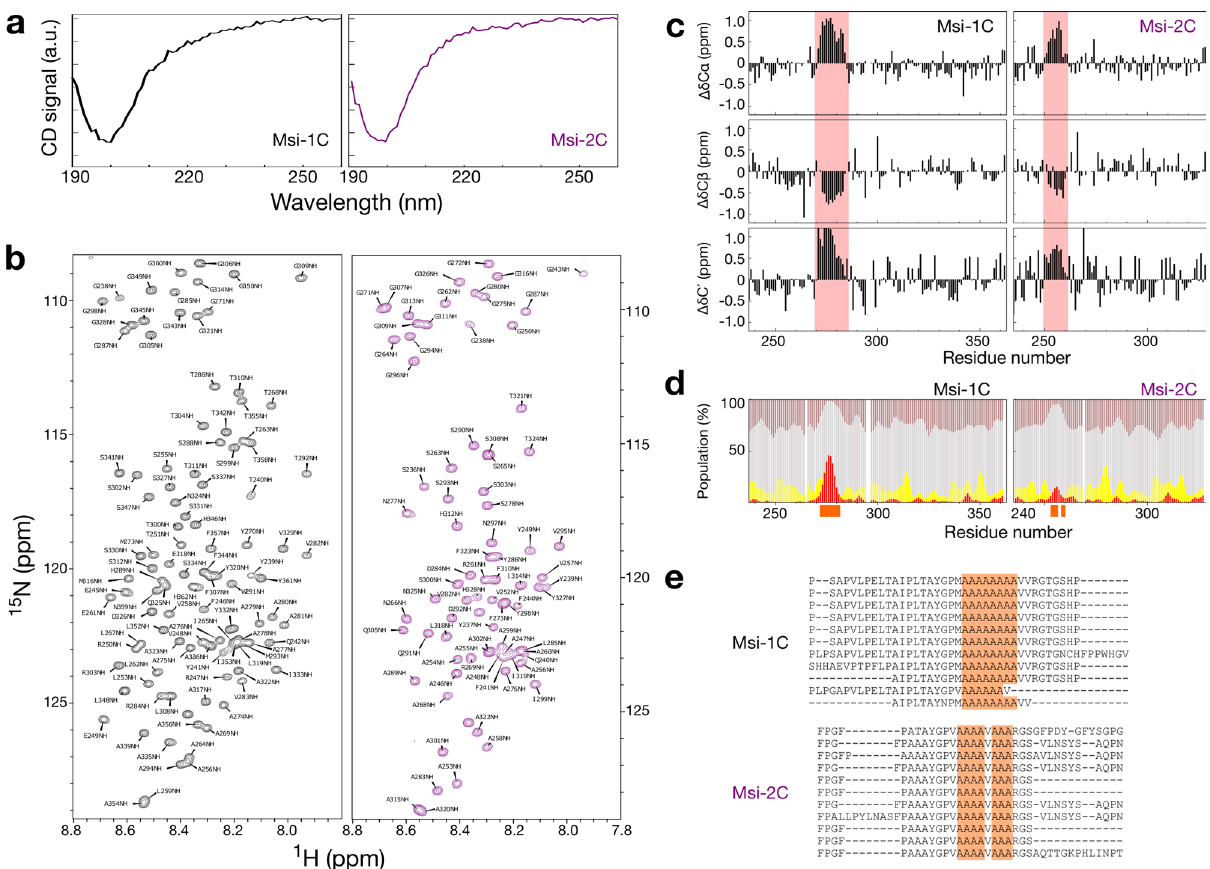
Fig. 2 The C-terminal domains of Musashi proteins are intrinsically disordered and have helix-forming polyalanine tracts. a Circular dichroism (CD) spectra of the C-terminal domains of Musashi-1 (black; Msi-1C) and Musashi-2 (purple; Msi-2C). b 15 N-edited NMR HSQC spectra of Msi-1C and Msi-2C with resonance assignments. c Secondary chemical shifts of C α , C β , and carbonyl-carbon (C ′ ). The most pronounced deviations are highlighted in red. d Stacked plots of the secondary structural populations derived from the chemical shifts using the δ 2D algorithm 34 . Red: α -helix; yellow: β -sheet; gray: random coil; brown: polyproline II helix. The alanines in the polyalanine tracts are indicated by orange blocks on the x -axis. e Multiple sequence alignment of Musashi homologs. The sequences are in the same order as shown in Fig. 1a. The polyalanine stretch is highlighted in orange. The CD and HSQC spectra were repeated at least three times for both protein